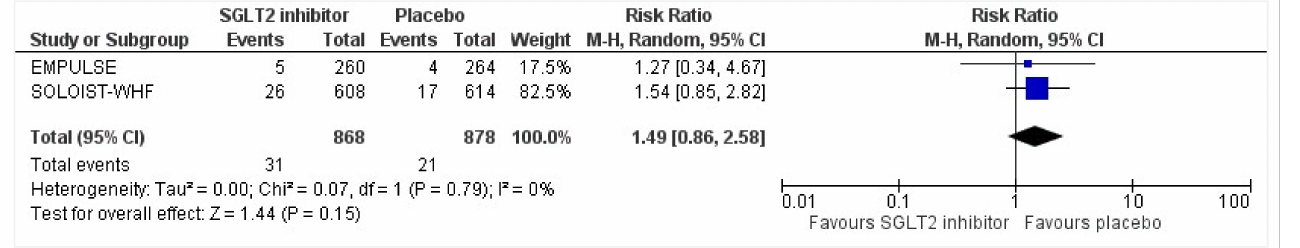
Figure 11. Forest plot for the total number of patients who had hypoglycemia as a serious adverse event in either group